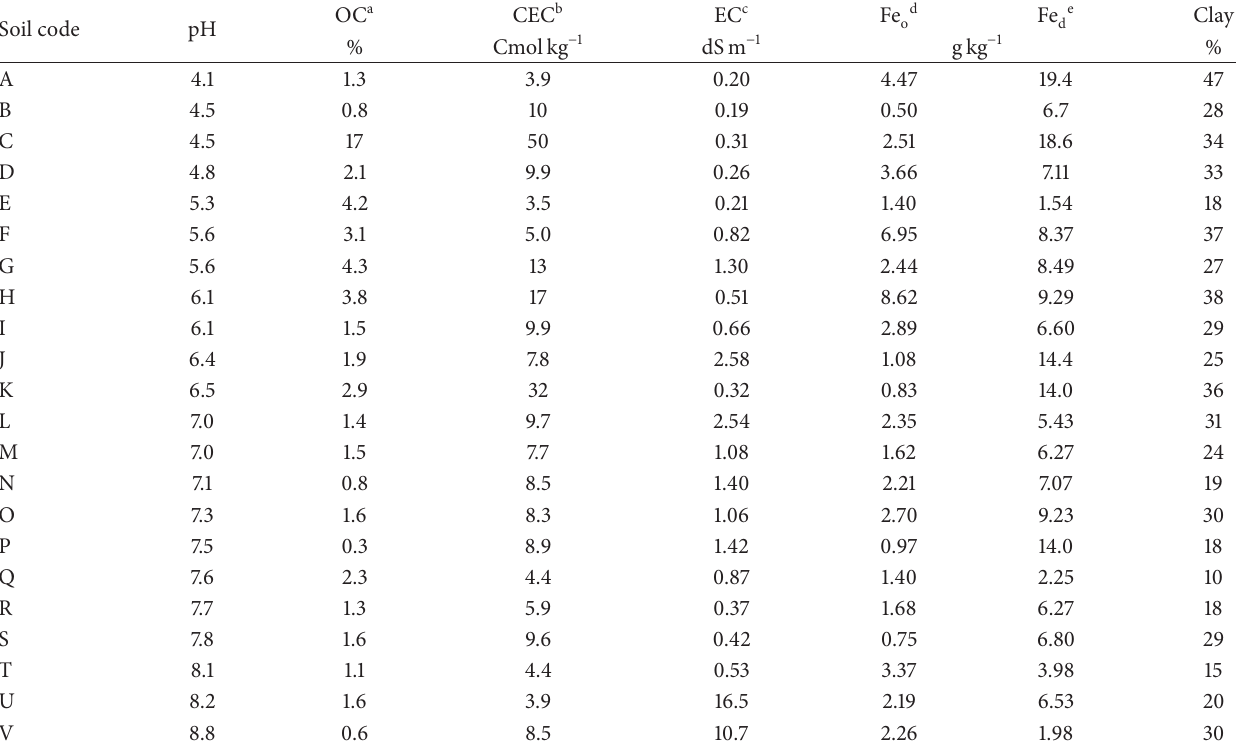
Table 3: Selected properties of the studied